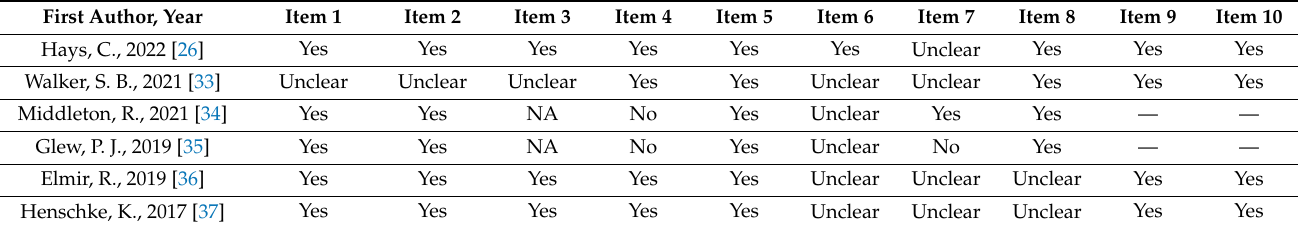
Table 2. Methodological quality assessment of included